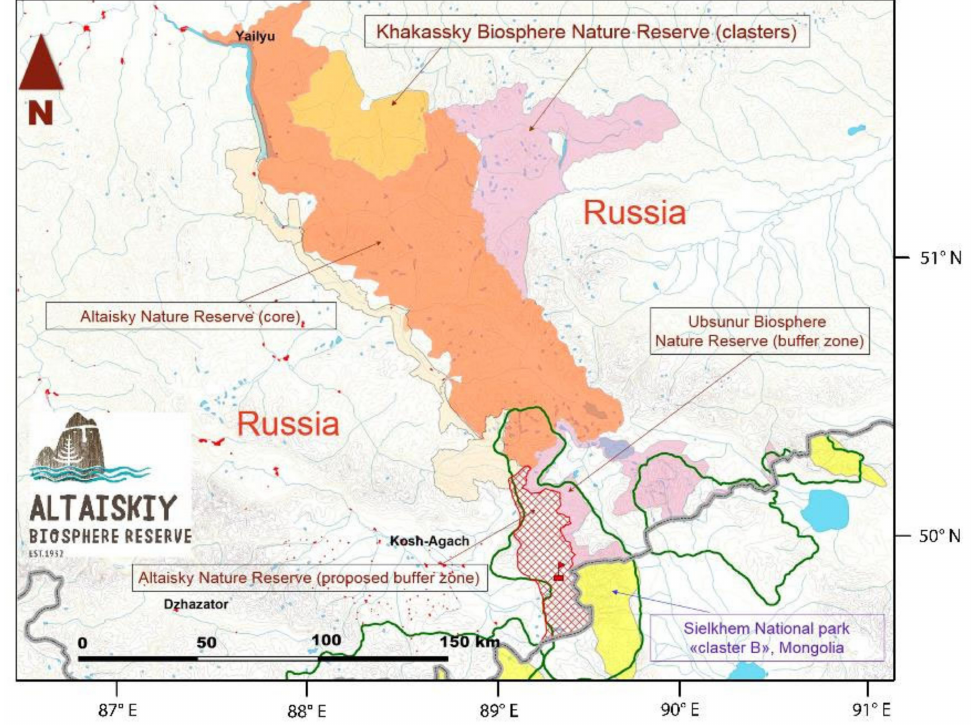
Figure 3. Altaisky Biosphere Reserve with other surrounding protected